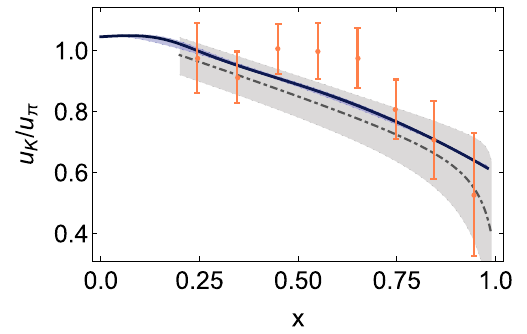
Fig. 13 Solidgreencurve–kaon’svalence ¯ s -quarkdistributiondefined at ζ H byEqs.(10),(47),evolved ζ H → ζ 5 usingtheprocedureexplained in Sect.4.1, including the splitting function modification in Eq.(59a) with σ s = 1. Dot-dashed blue curve – kaon’s valence u -quark distri- bution, unchanged from Fig.11. Dashed black curve – central ¯ s -quark distribution from Fig.11, i.e. obtained with mass-independent evolu- tion. (The bands bracketing the central DFs reflect the uncertainty in the k 2 = 0 value of the PI charge, Fig.1